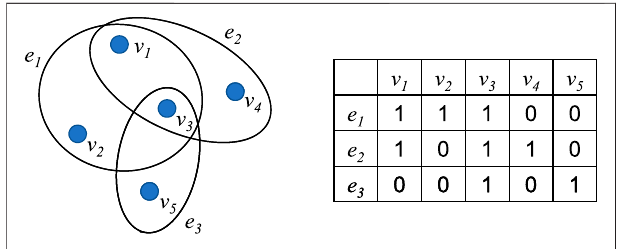
FIGURE 3 | A hypergraph and its association matrix